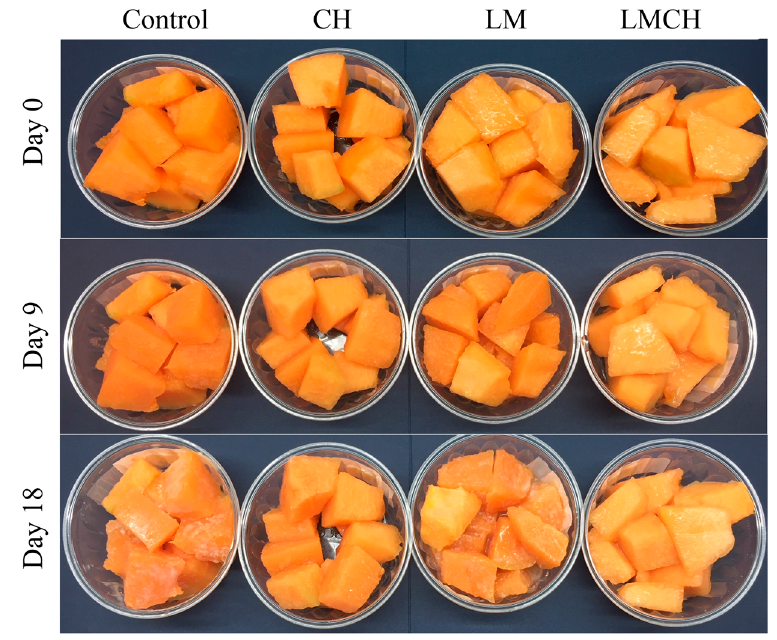
Figure 6. Appearance of fresh-cut cantaloupe with and without an edible coating (control) after 0, 9, and 18 days of storage at 4 °C.